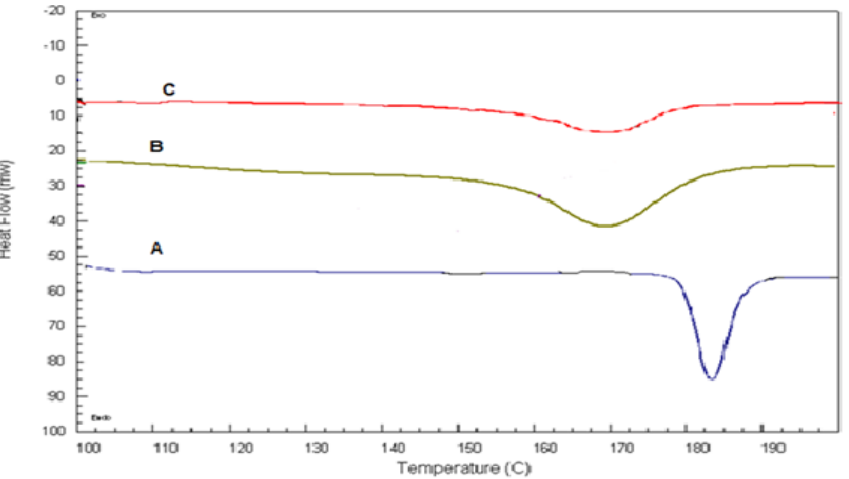
Figure 4. DSC thermograms of A: Pure QTF, B: lecithin, cholesterol, and QTF physical mixture, C: the optimized formula.